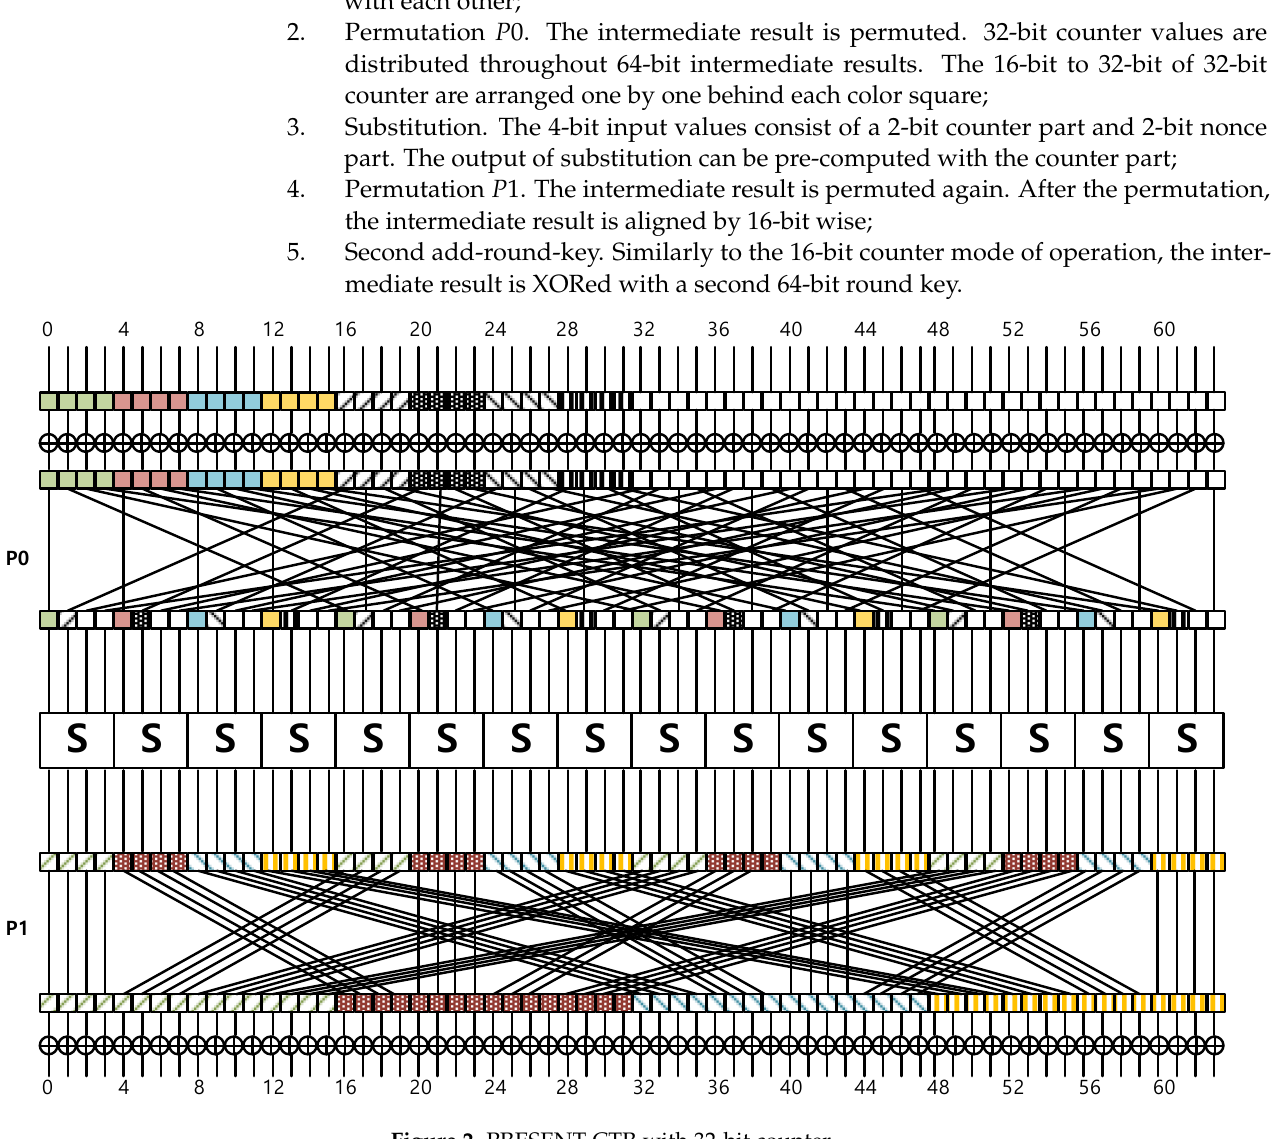
Figure 2. PRESENT-CTR with 32-bit